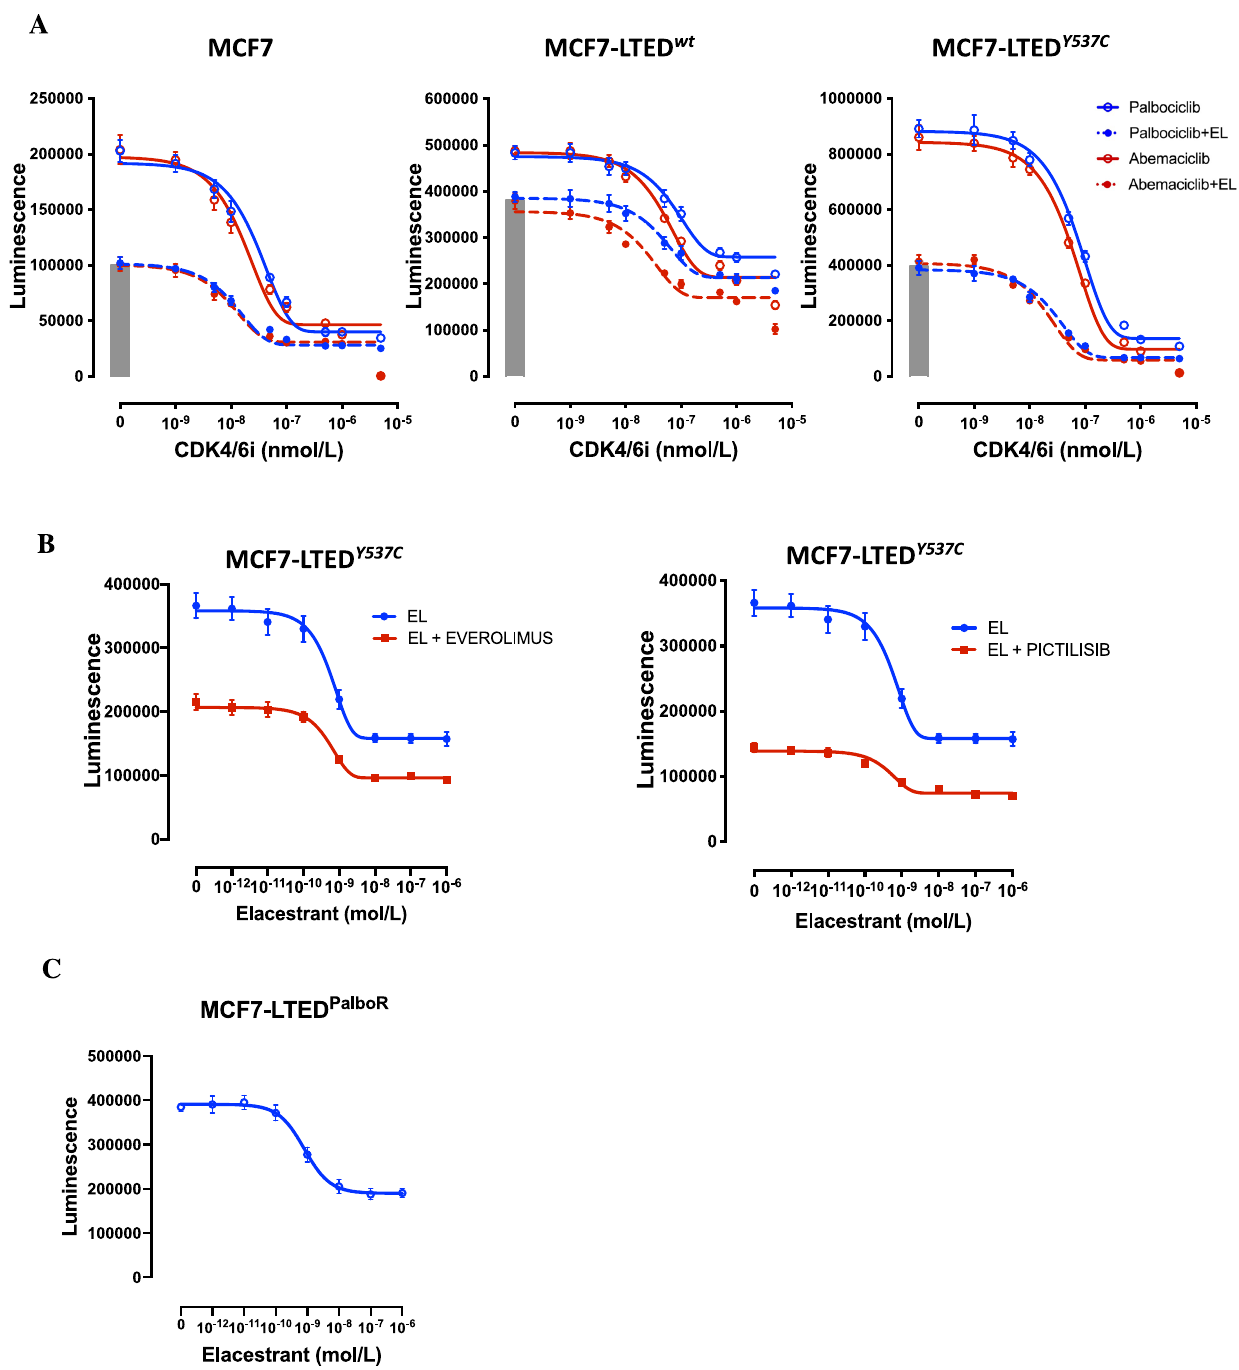
Fig. 6 Effect of elacestrant in combination with targeted therapies. A Effect of escalating doses of palbociclib or abemaciclib with or without elacestrant in MCF7 (0.5 nM), MCF7-LTED wt (20 nM) and MCF7-LTED Y537C (1.5 nM) indicated by the bar in each graph. B Effect of escalating doses of elacestrant, with or without everolimus (5 nM) or pictilisib (100 nM) in MCF7-LTED Y537C . C Effect of escalating doses of elacestrant in MCF7-LTED PalboR . Data represented are mean ± SEM ( n = 3 biological experiments with six technical